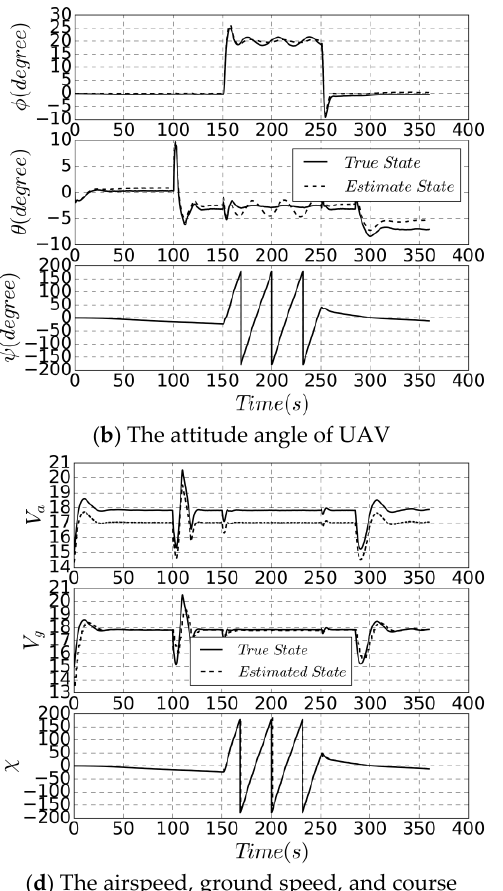
Table 7. The error precision of flight parameters in different phases.